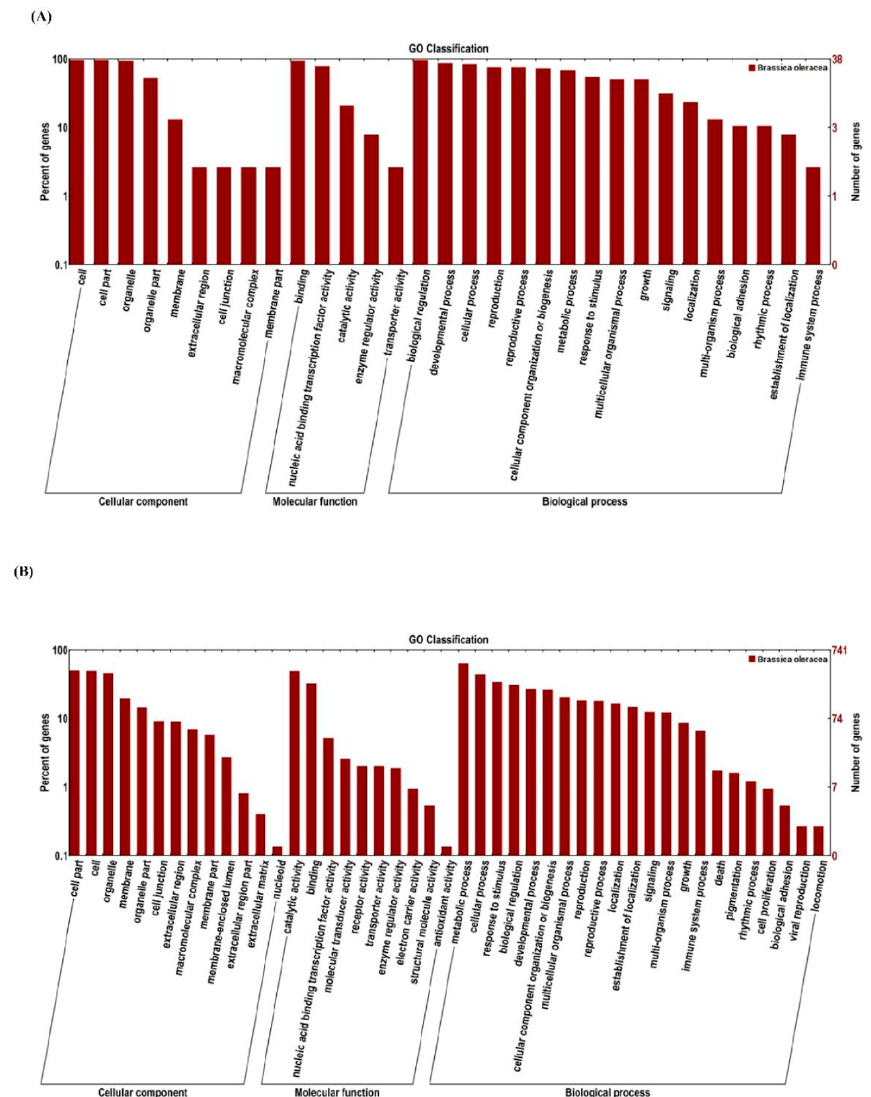
Figure 6. Gene categories and distribution of miRNAs targets in cabbage. ( A ) Gene categories and distribution of target genes for known miRNAs. ( B ) Gene categories and distribution of target genes for novel miRNAs.